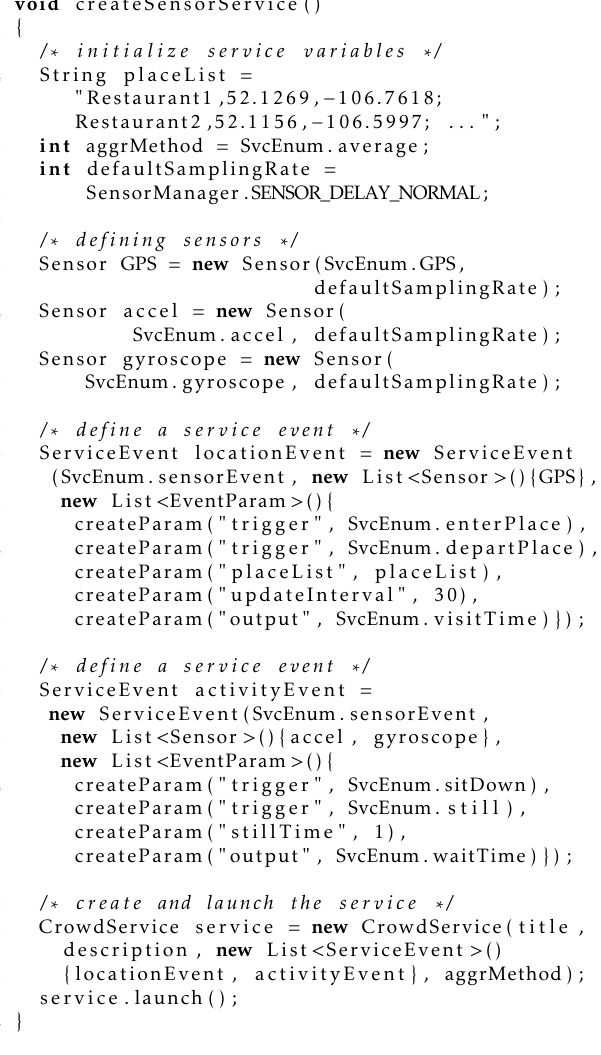
Figure 9. Restaurant Recommendation Service